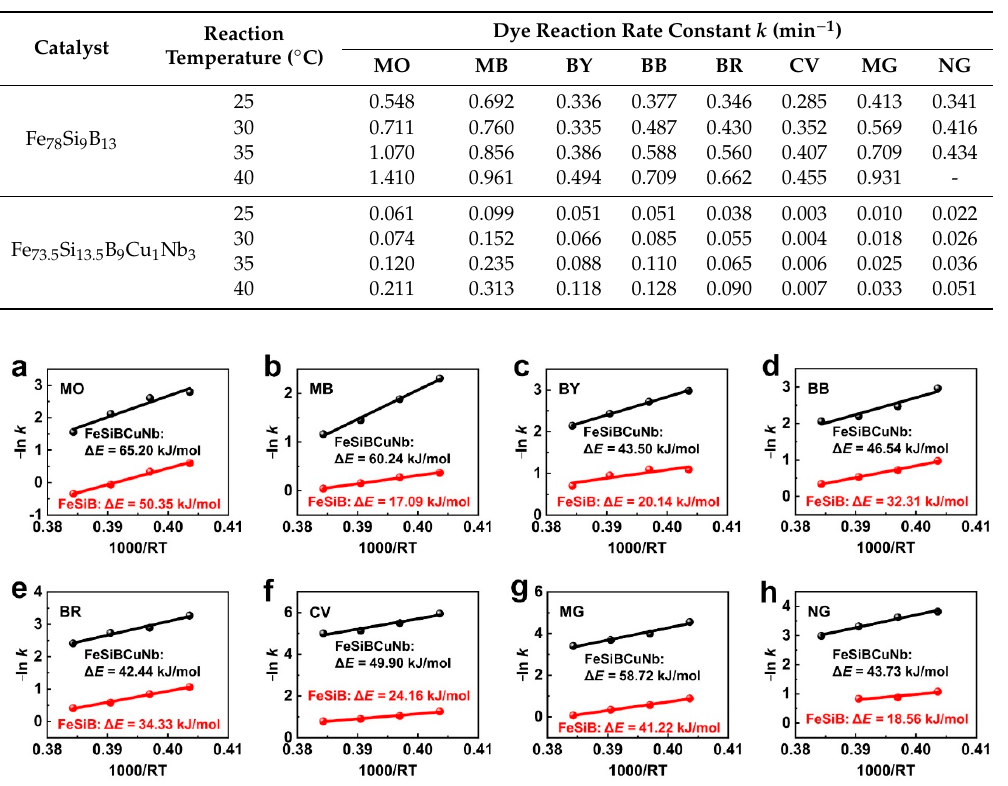
Figure 4. Activation energy Δ E of Fe 78 Si 9 B 13 (FeSiB) and Fe 73.5 Si 13.5 B 9 Cu 1 Nb 3 (FeSiBCuNb) metallic glass ribbons for ( a ) MO, ( b ) MB, ( c ) BY, ( d ) BB, ( e ) BR, ( f ) CV, ( g ) MG and ( h ) NG dyes.